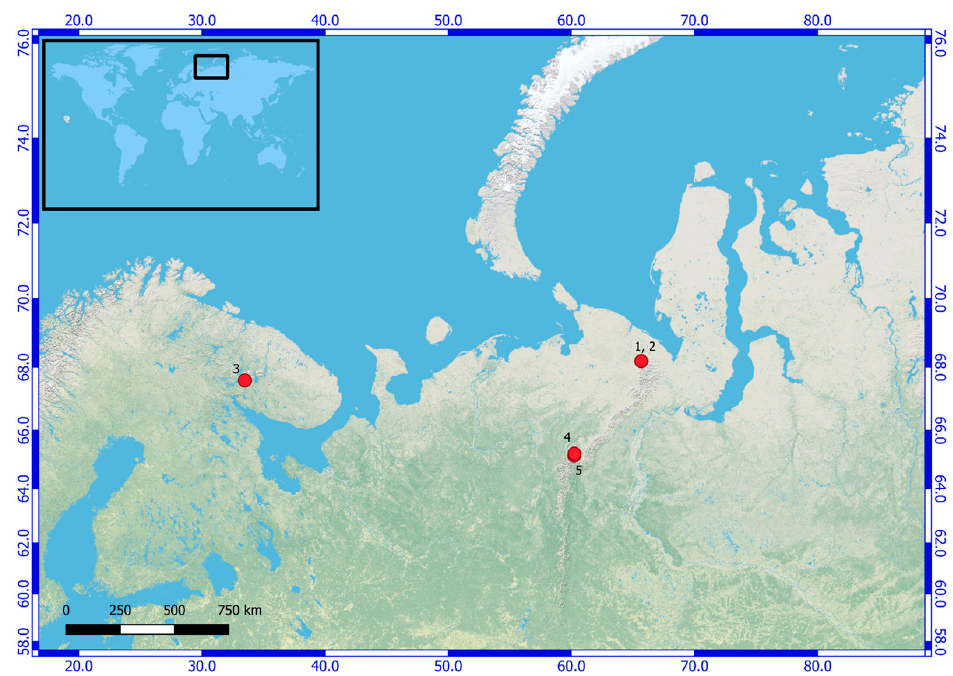
Figure 1. The position of the sample plots of Drouetiella strains; numbers of sample plots as outlined in Table 1.